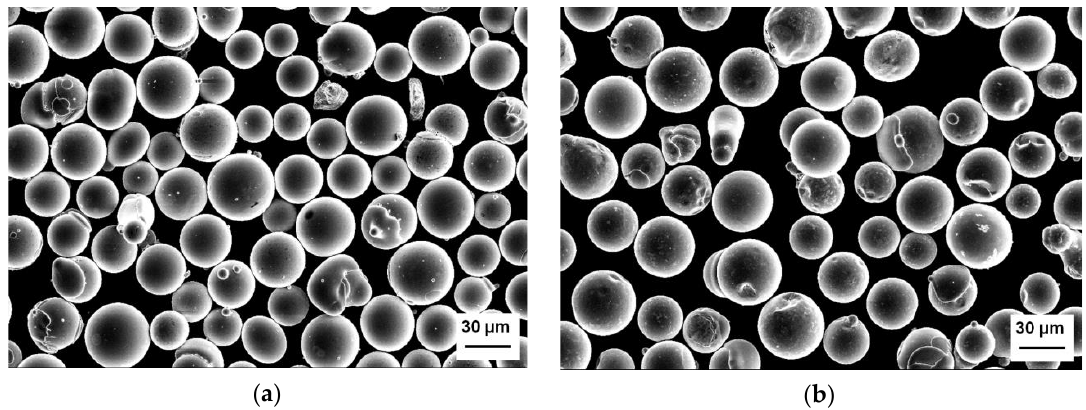
Figure 2. Morphology of the Fe-based alloy powders: ( a ) glassy Fe 66 Cr 10 Nb 5 B 19 and ( b ) crystalline Fe 62 Cr 10 Nb 12 B 16 (20 –40 μm fraction).